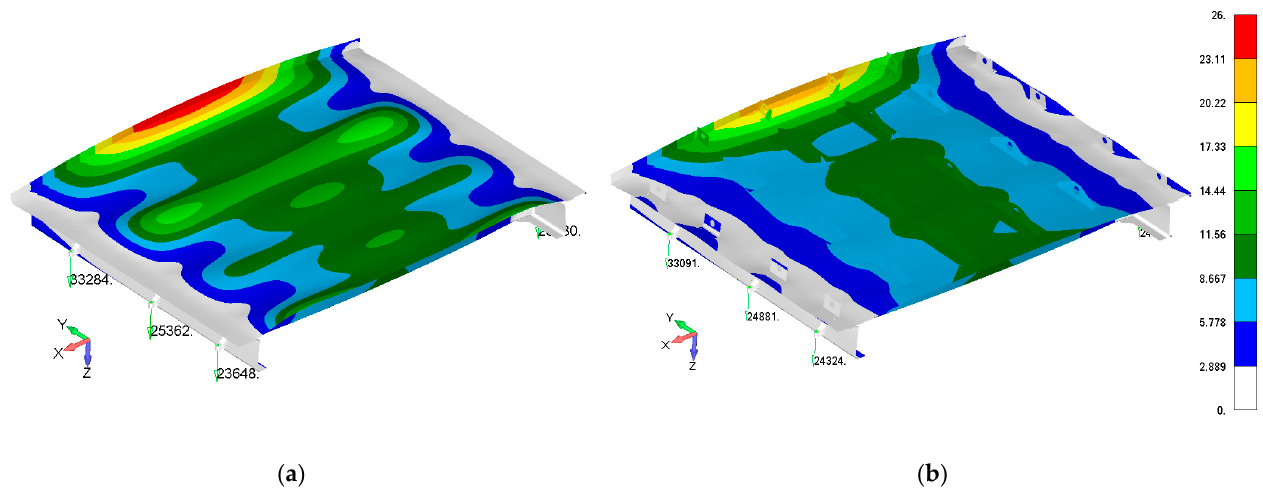
Figure 6. Comparison of the reference overpressure deformation map in mm ( a ) with a substitute points load ( b ) of the door panel.